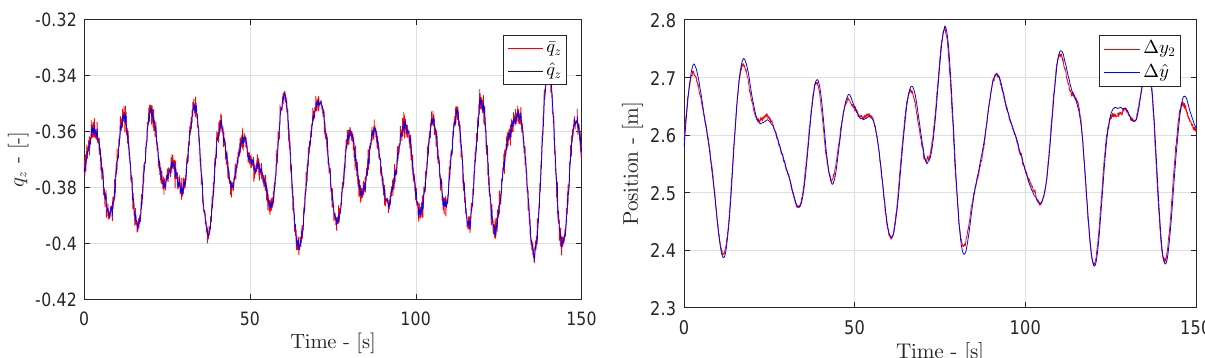
Figure 18: Sensor fusion performance in y-direction.